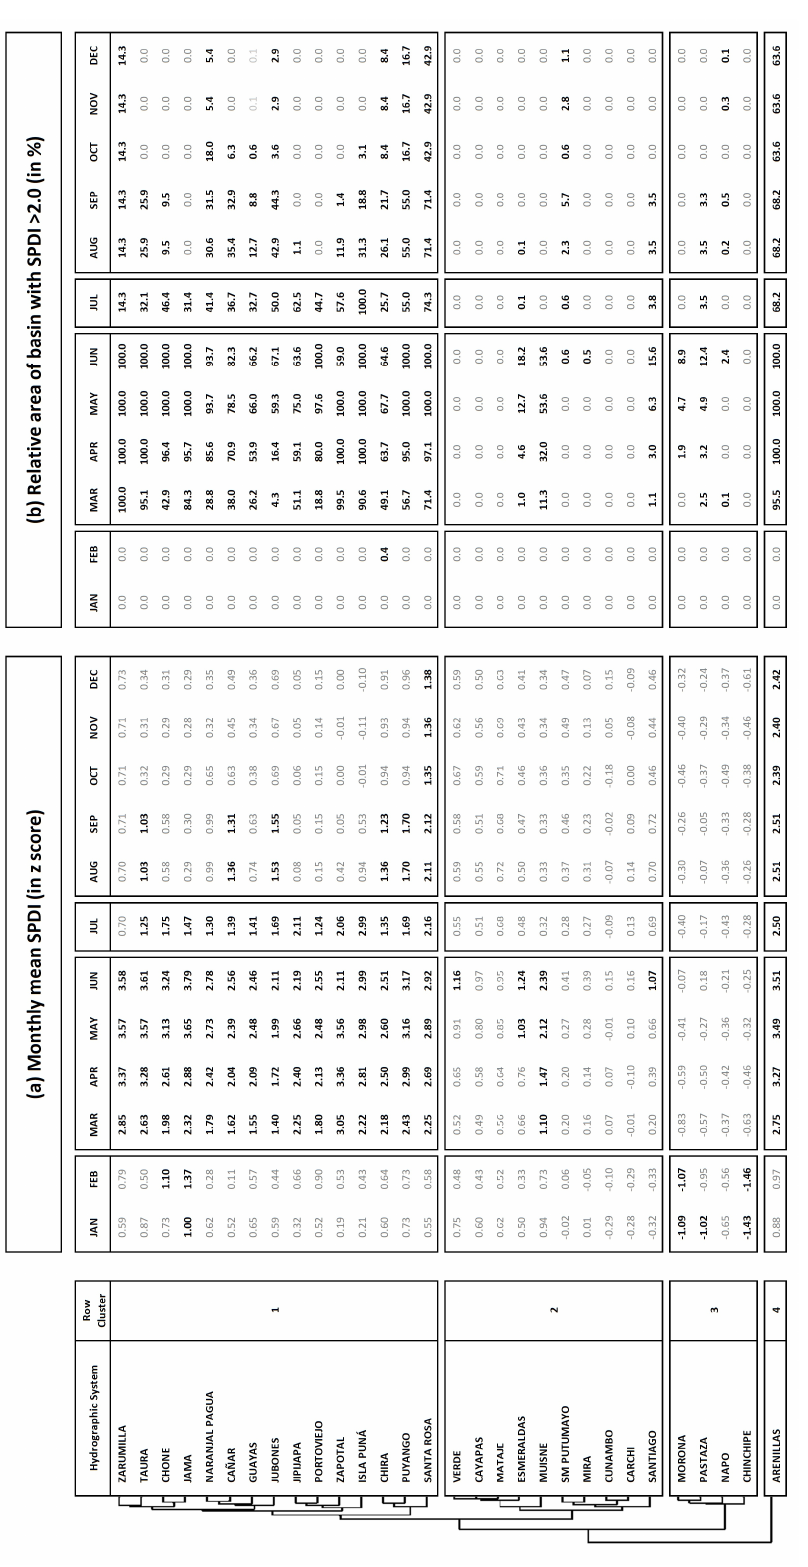
Table 4. Standardized Precipitation Drought Index (SPDI) temporal and spatial dynamics at the different hydrographic systems for the year 2017 of the coastal El Niño (COA17). Cluster analysis ( K -means clustering using Euclidean distance) was performed on both rows and columns and with the statistical tool ClustVis (Metsalu and Vilo,